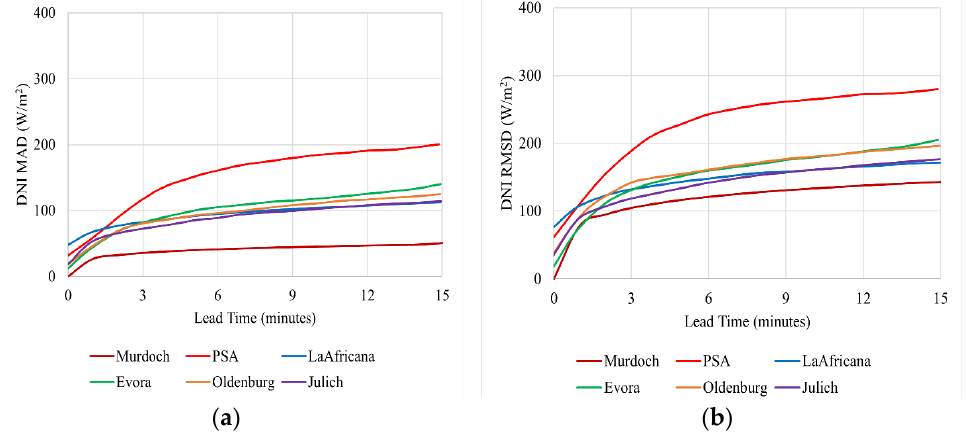
Figure 17. ( a ) DNI MAD for Overcast class. ( b ) DNI RMSD for Overcast class.